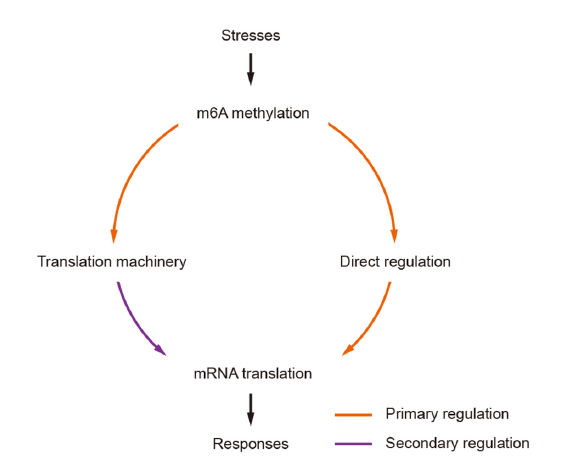
FIGURE7 A model of secondarily amplified regulation of mRNA translation by m6A methylation. The changes of m6A methylation status (methylated/demethylated) induced by stresses are transferred to stronger translation regulators by primarily affecting the translation of mRNAs encoding components in translation machinery, which would result in more profound and strong impacts to mRNA translation, facilitating effective and prompt responses to